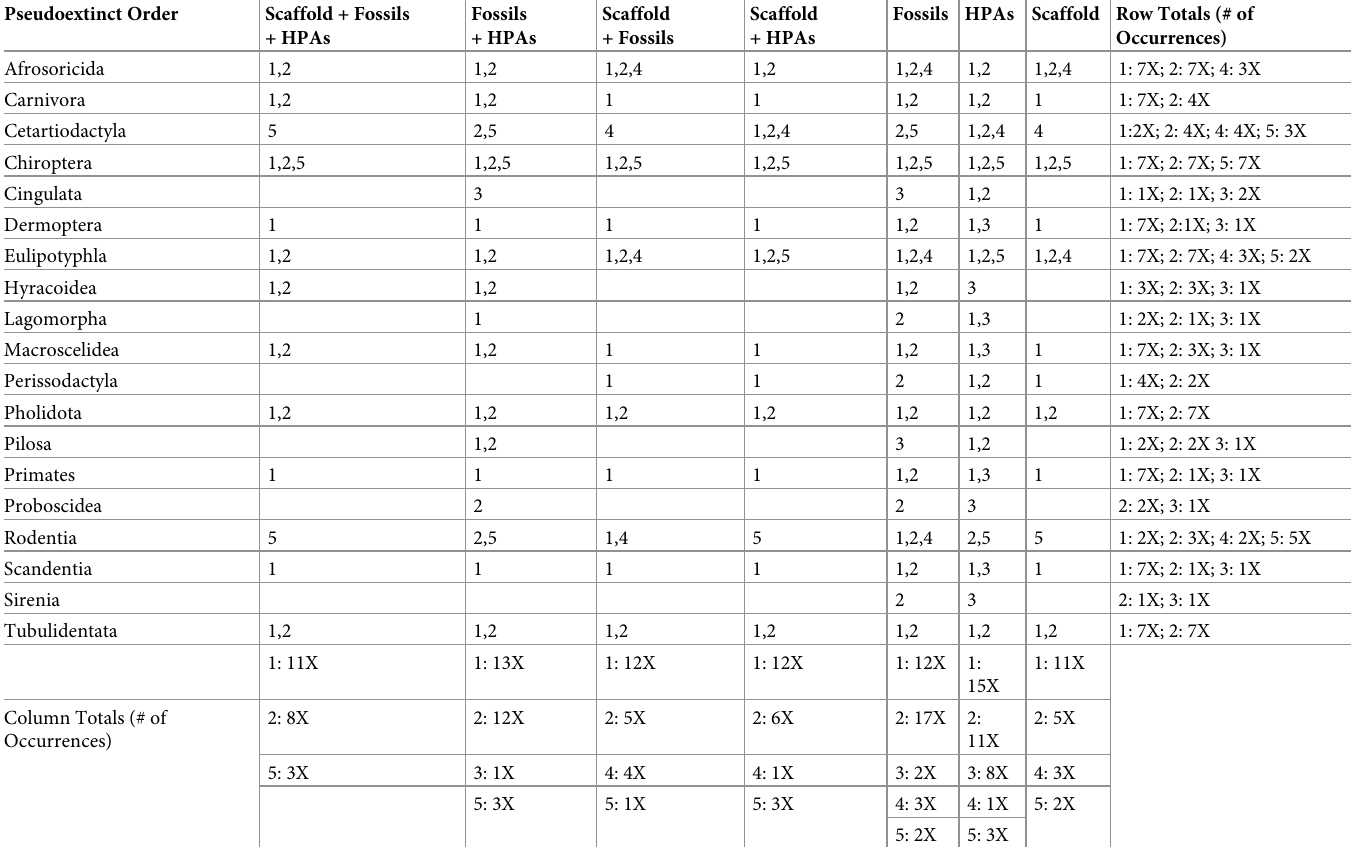
Table 2. Summary of misplacements of pseudoextinct taxa relative to the molecular scaffold. Pseudoextinct